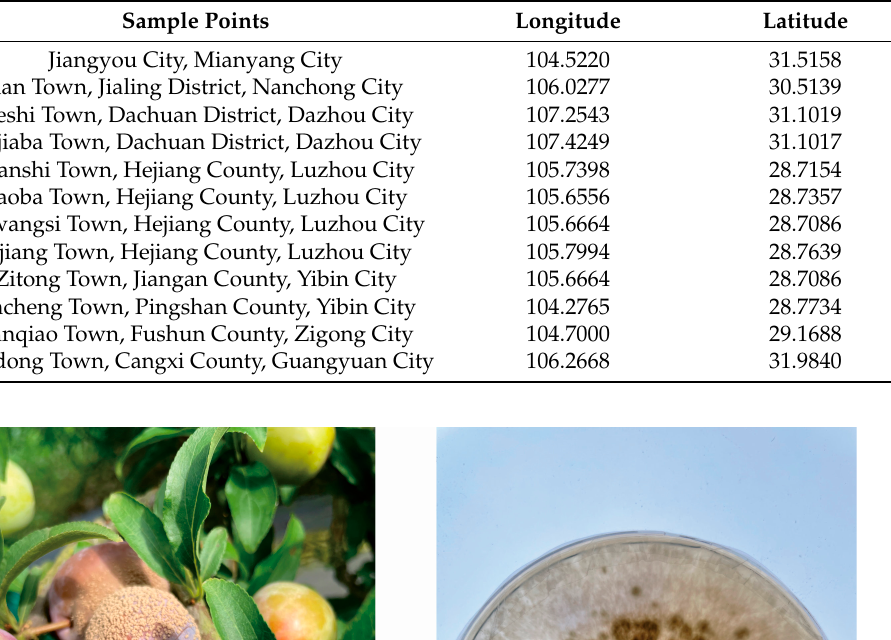
Table 3. List of location, longitude, and latitude of plum sample points.